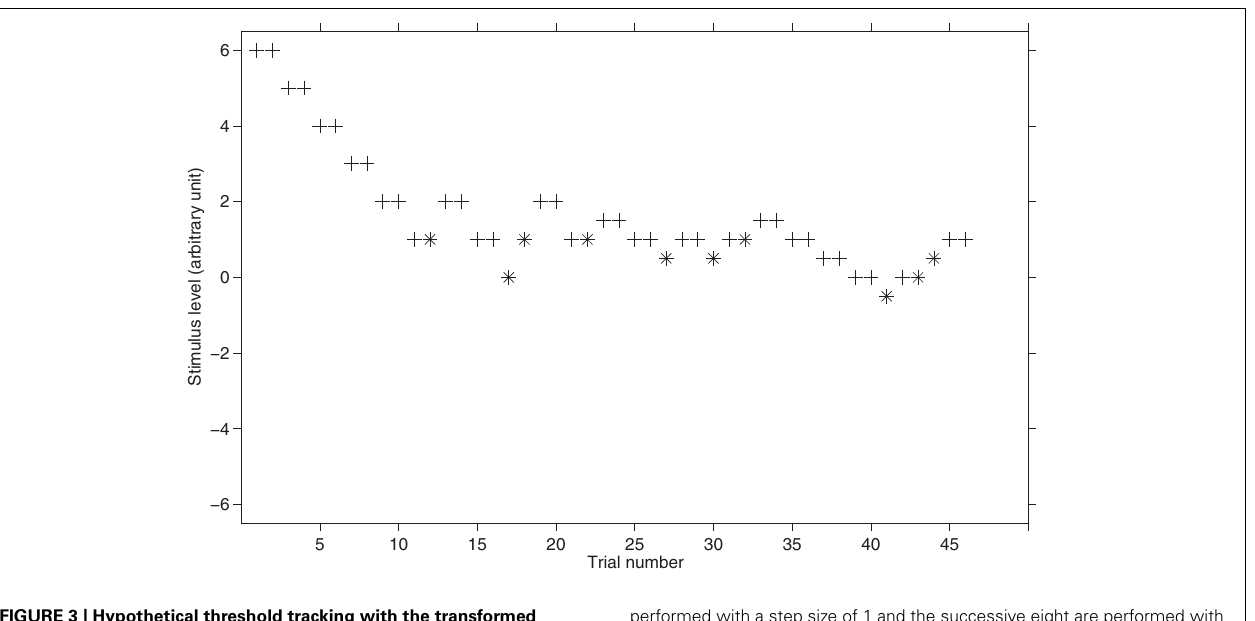
performed with a step size of 1 and the successive eight are performed with a step size of 0.5. Note how the transformed rule lengthens the threshold tracking in comparison with the method of limits or the simple up-down procedure (see Figure 2